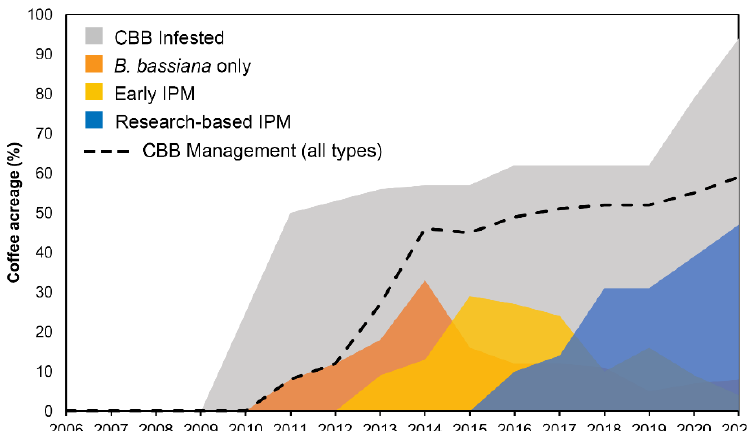
Figure 2. Coffee berry borer (CBB) infested acreage as a proportion of all coffee acreage in Hawaii (gray), acreage for each of the three management types ( B. bassiana only, Early IPM, and Research- based IPM) as a proportion of infested acreage, and total CBB managed acreage as a combination of all three management types (dashed